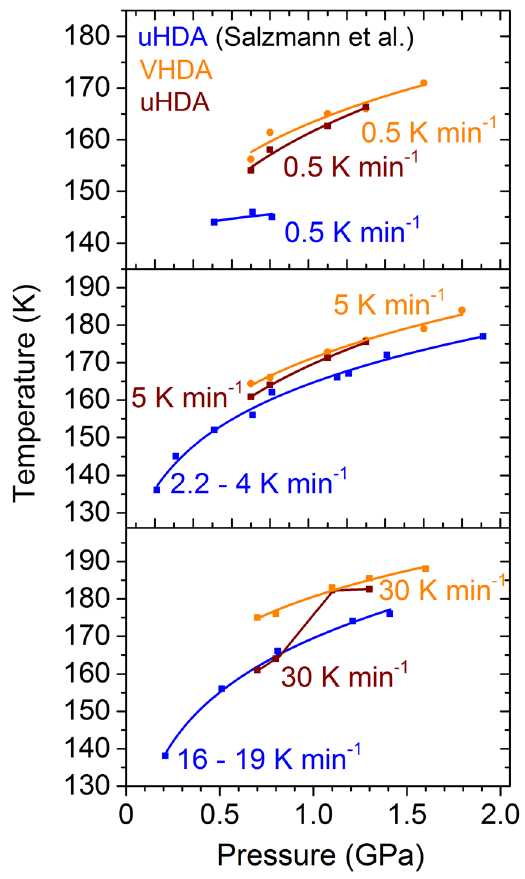
Figure 4. Crystallisation temperatures T x of VHDA (orange) are compared to those of uHDA (brown) and to literature 30 (blue) for ( a )) slow, ( b )) intermediate and ( c )) fast